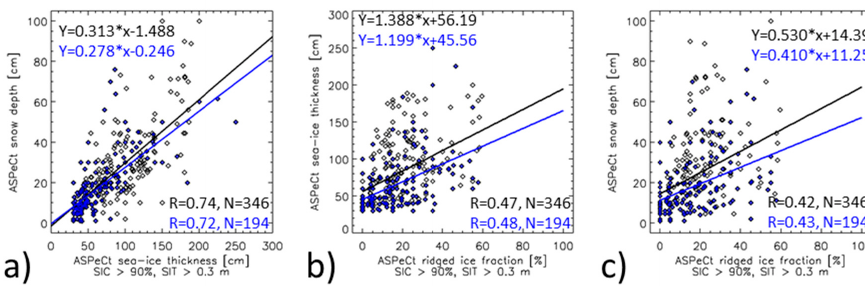
Figure 3. The information content of the used ASPeCt data. The black symbols denote all the data, and the blue symbols denote the data at air temperatures < − 10 °C. ( a ) The snow depth versus sea-ice thickness; ( b ) The sea-ice thickness versus ridged ice fraction; ( c ) The snow depth versus ridged ice fraction.